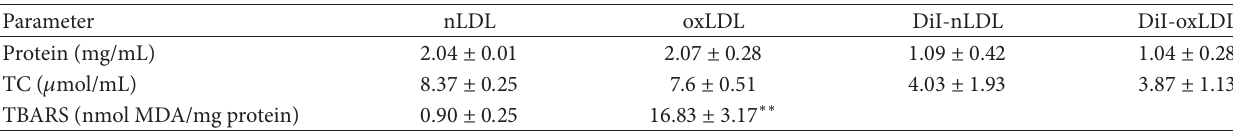
Table 3: Composition of LDL: human LDL was isolated from plasma by sequential density gradient ultracentrifugation, oxidised using , and labelled with DiI as described in the Methods section. Data shown are the mean ± SEM from 3 preparations. CuSO 4